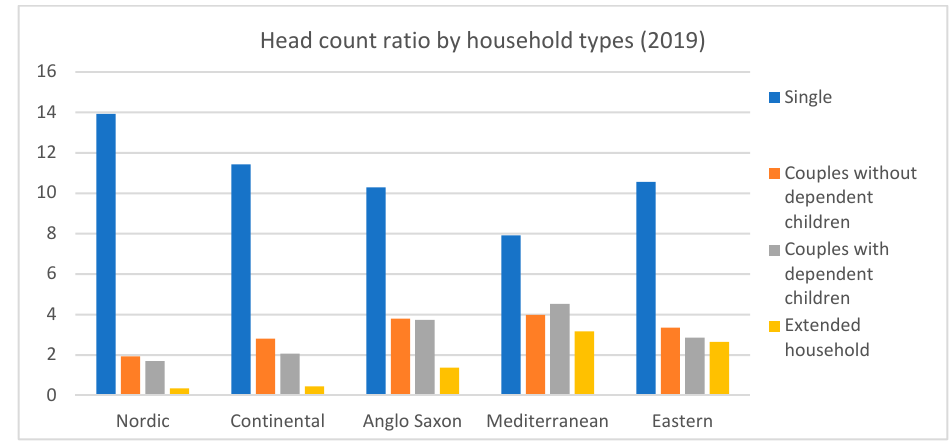
Figure 7. Source: elaboration on Eurostat data.